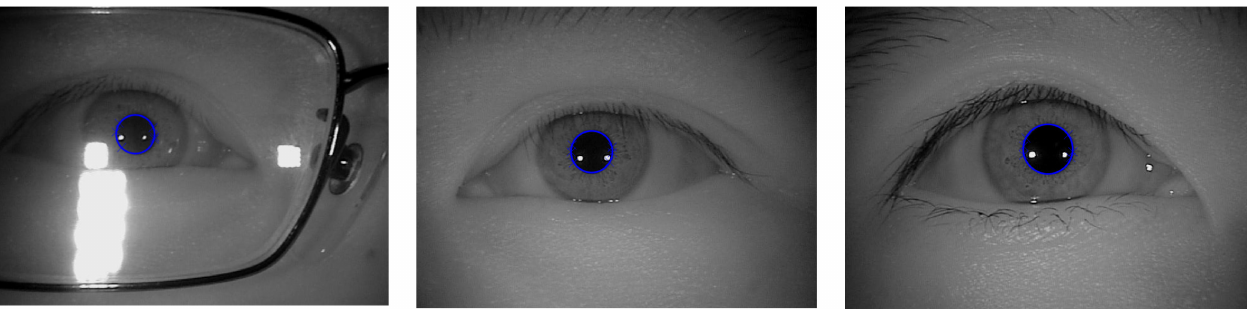
Figure 10. Example results of inner boundary estimation.